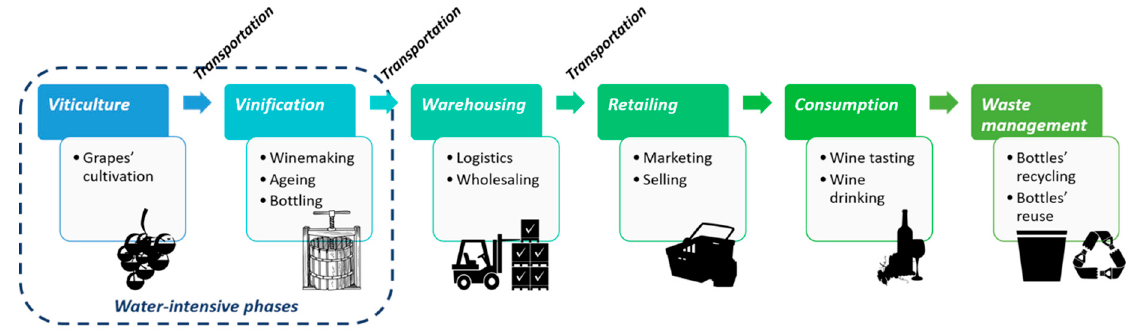
Figure 1. Typical wine supply chain.